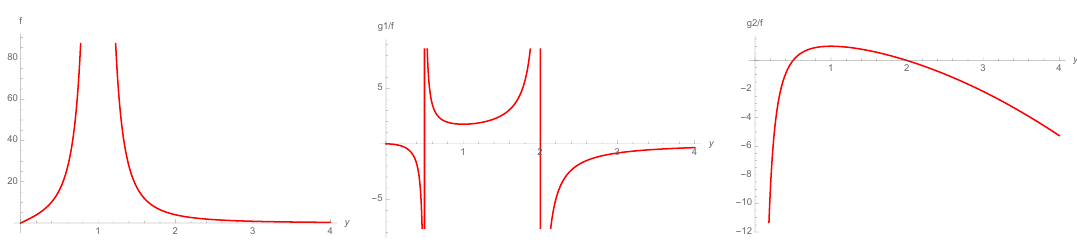
Figure 3 . A representative solution with g = 1 / 4 , b = − 1 . 5 and C = 1 . The solution is regular in the range of y = 0 . 5 < y < y = 2 . 0 1 2